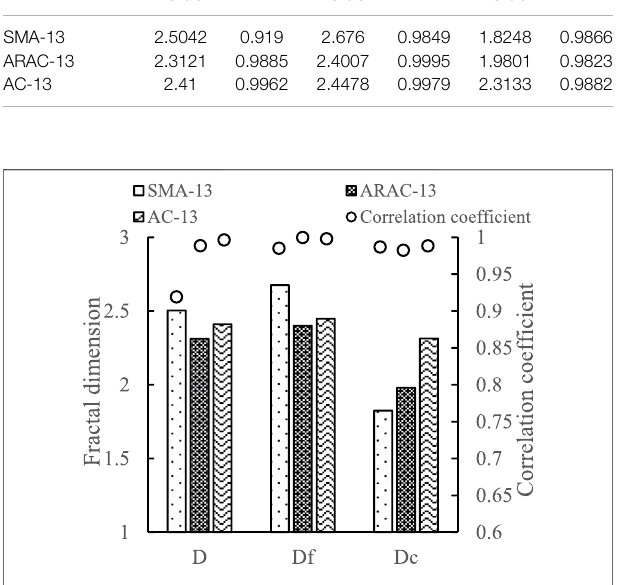
FIGURE 6 | Three fractal dimensions with different gradations and their correlation coef fi cients.